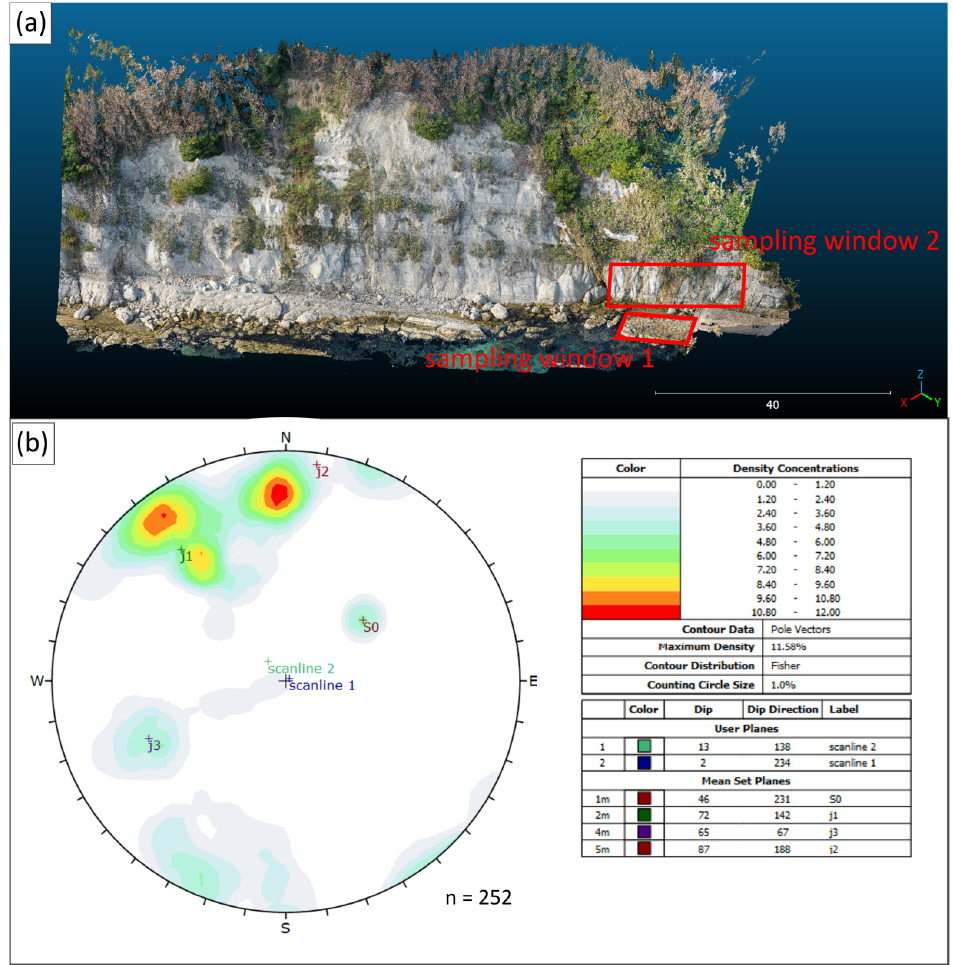
Figure 4. ( a ) 3D model with indication of the sampling windows used for the P 21 determination and the DFN modelling; ( b ) stereonet with pole vector plot (lower hemisphere, equal angle) with indication of mean set dip angle and dip direction of the planes. Table 2. Discontinuity set characteristics from the geomechanical survey. n.d. = not detected.